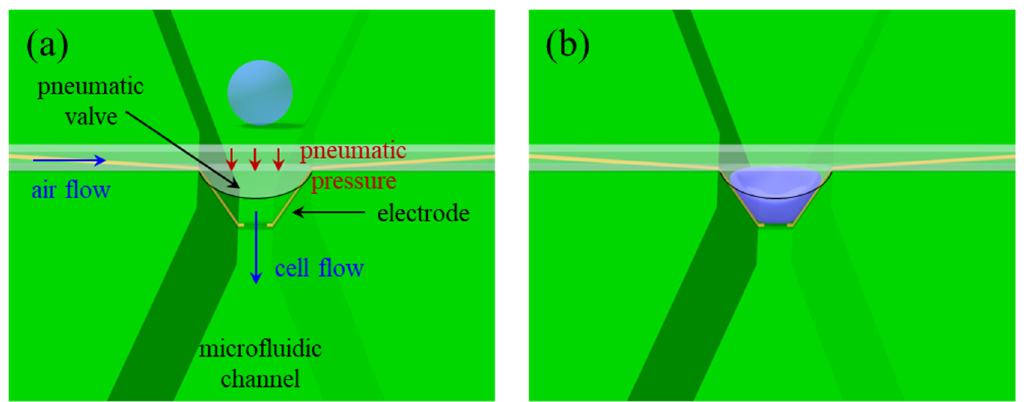
Figure 1. Configuration of the µ EIS device equipped with a pneumatic valve for flow cytometry. ( a ) An unpressed cell before passing through the pneumatic valve, and ( b ) a cell squeezed by the pneumatic valve. Discrimination sensitivity can be enhanced on the basis of tight contact between the cell and electrode in the constricted